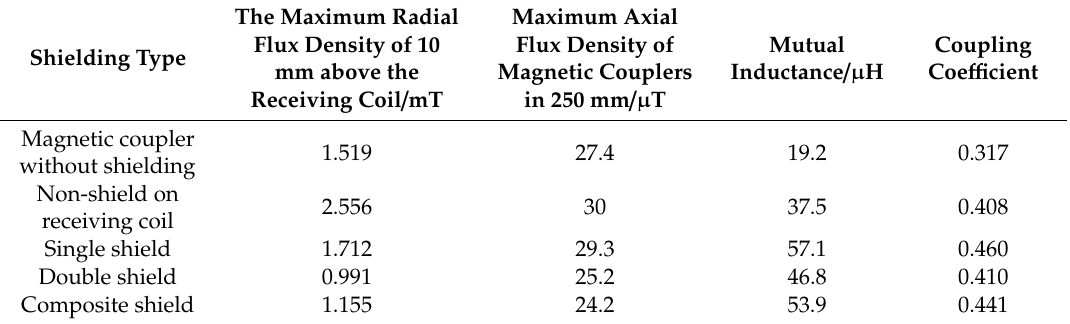
Table 4. Data of di ff erent magnetic coupling structures.